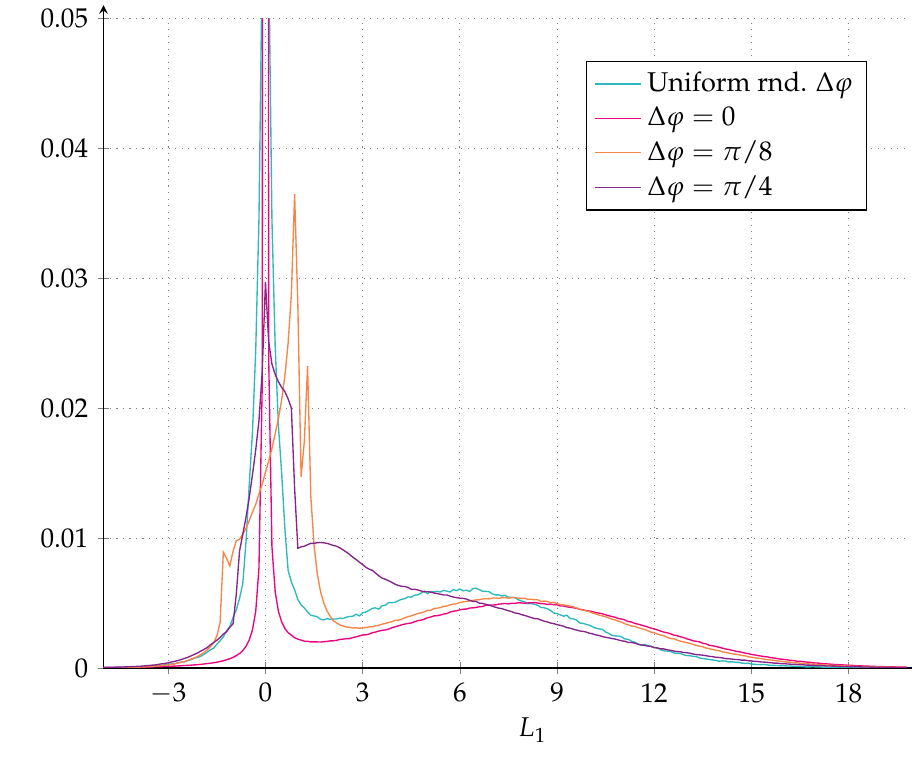
Figure 5. Probability density function of the bit LLRs assuming AWGN and a symbol-synchronous QPSK interferer uniform at random phase (rnd. in the caption), or with a fixed phase offset when E s / N 0 = 6